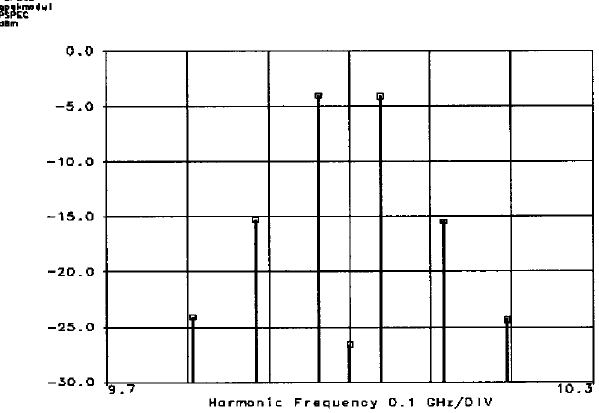
FIGURE 27 Discrete power spectral density of the output QPSK signal.